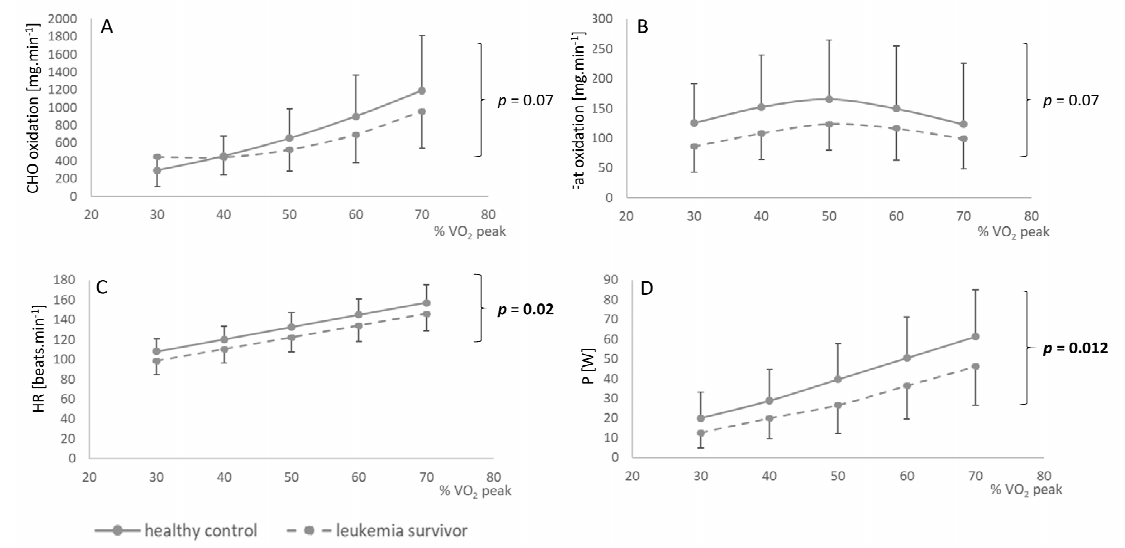
Figure 2. Fat ( A ) and carbohydrate ( B ) oxidation rate, heart rate ( C ), and power ( D ) according to percentage of VO 2 peak. Data are means ± SD.